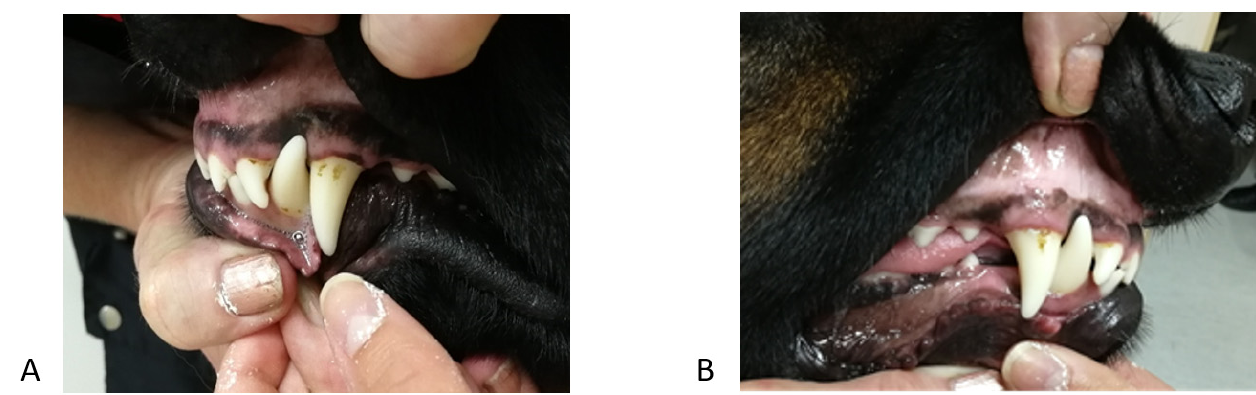
Figure 2. First case. Images in the occlusal projection. ( A ) mandibular arch, ( B ) maxillary arch—the arrow marks the recess. right (R) and left (L)